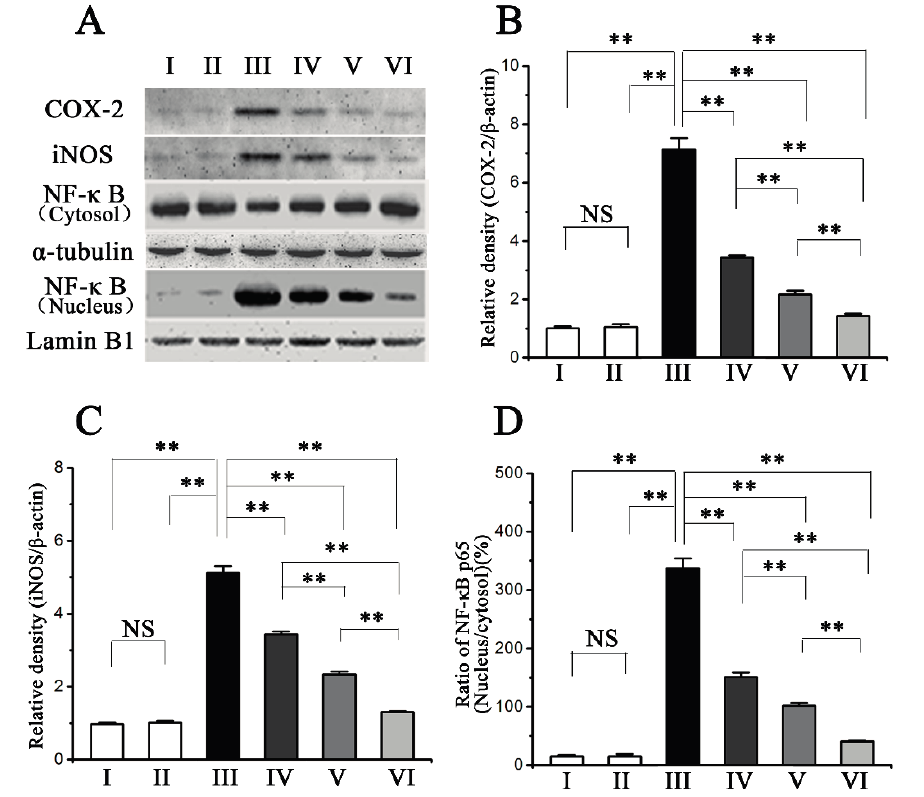
Figure 4. Pretreatment effects of procyanidin B2 on CCl 4 -induced expression of inflammatory mediators. ( A ) Western blot analysis of COX-2, iNOS and NF- κ B proteins in response to CCl 4 and procyanidin B2; ( B ) Relative density analysis of COX-2 protein bands; ( C ) Relative density analysis of iNOS protein bands; ( D ) Relative density of the analysis of the NF- κ B p65 protein bands expressed as the ratio in nucleus and cytosol. The normal control is set as 1.0. Values expressed as mean ± SE in each group. NS: no significant, ** p < 0.01, n = 7. Animals were divided into following groups: I, normal control; II, procyanidin B2 control; III, model; IV, procyanidin B2 (25 mg·kg − 1 ) + CCl 4 ; V, procyanidin B2 (50 mg·kg − 1 ) + CCl 4 ; and VI, procyanidin B2 (100 mg·kg − 1 ) + CCl 4